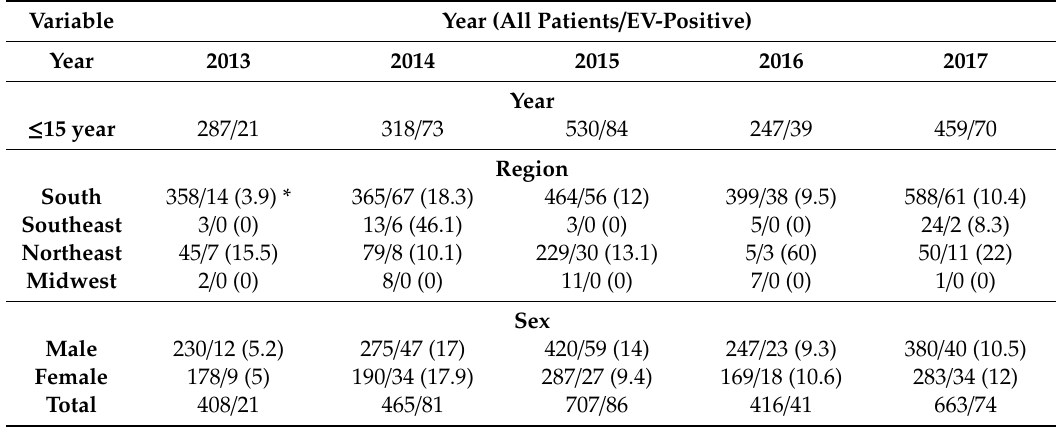
Table 1. Demographic features of aseptic meningitis patients in Brazil, 2013–2017.